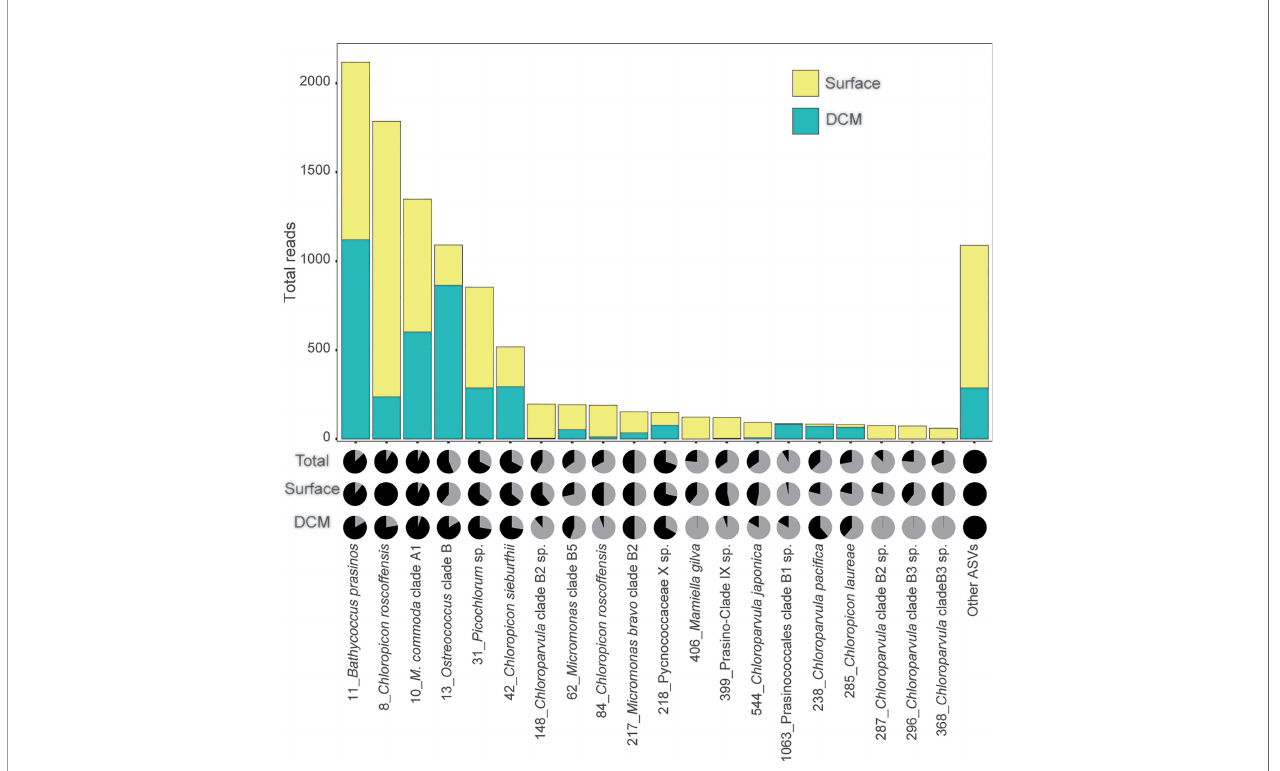
FIGURE 3 | Rank-abundance for the 20 most abundant chlorophyte ASVs generated from the DNA of 0.2-3 m m size-fraction from the surface and DCM samples in the ECS, with a minimum of 400 reads subsampled 100 times. Surface subsamples (28 samples) are shown in yellow, while DCM subsamples (18 samples) are shown in turquoise. The pie charts show the reads prior to subsampling. The upper, middle and lower pie charts represent total (50 samples), surface (30 samples), and DCM (20 samples) samples respectively. The numbers next to the taxonomic annotations indicate the